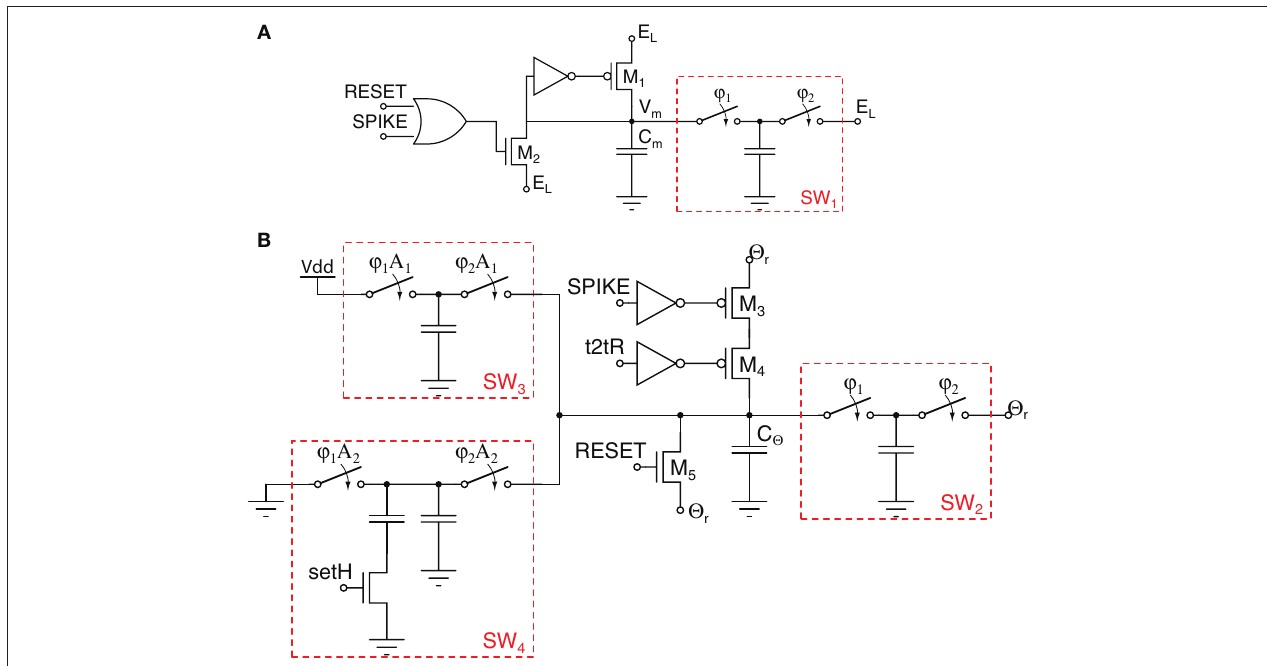
FIgure 18 | Switched-capacitor Mihalas–Niebur neuron implementation. (a) Neuron membrane circuits; (b) adaptive threshold circuits.